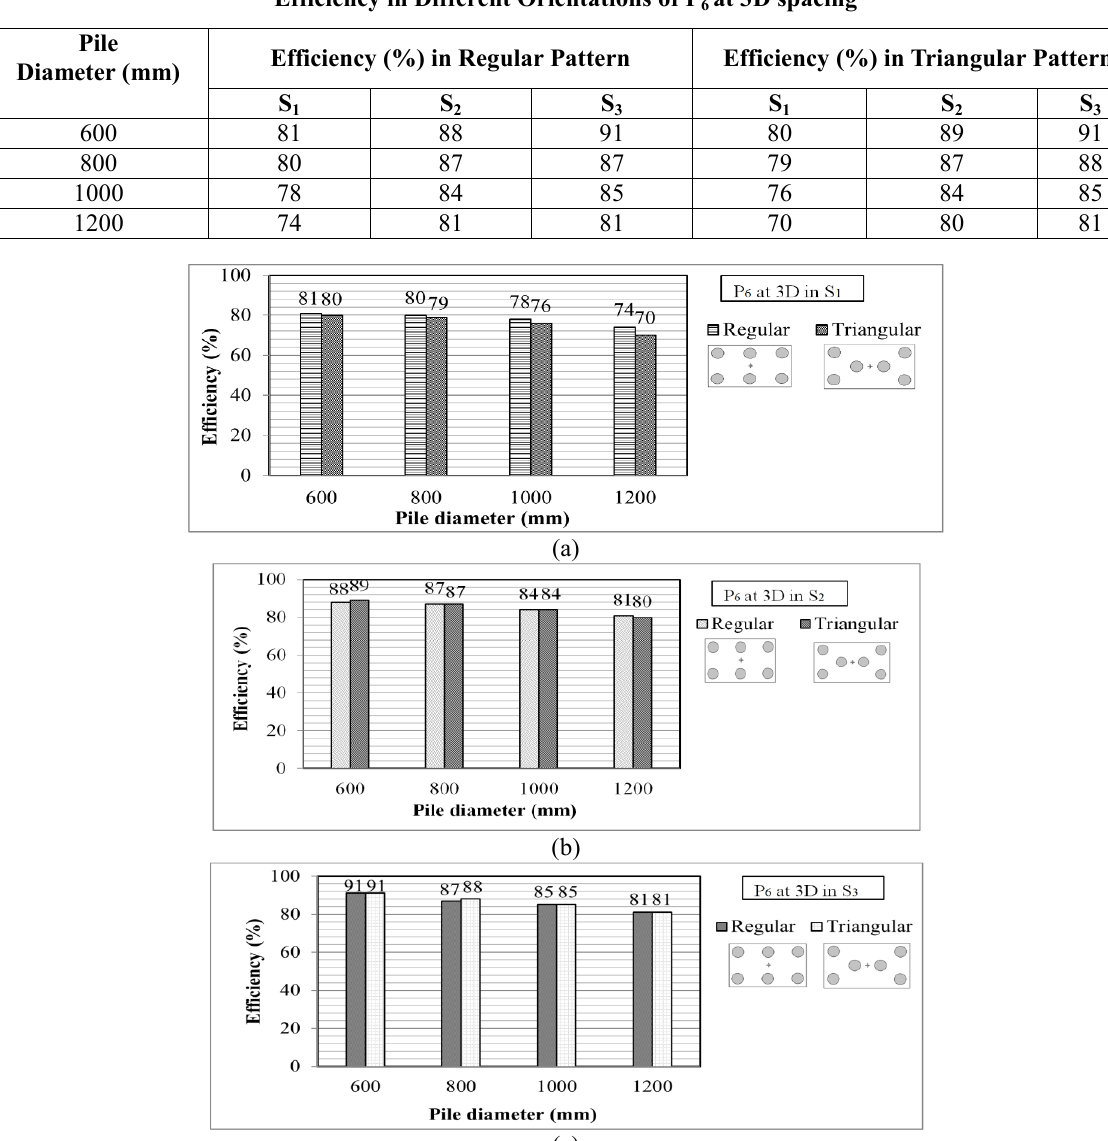
Efficiency of group of 6 piles in two orientations.